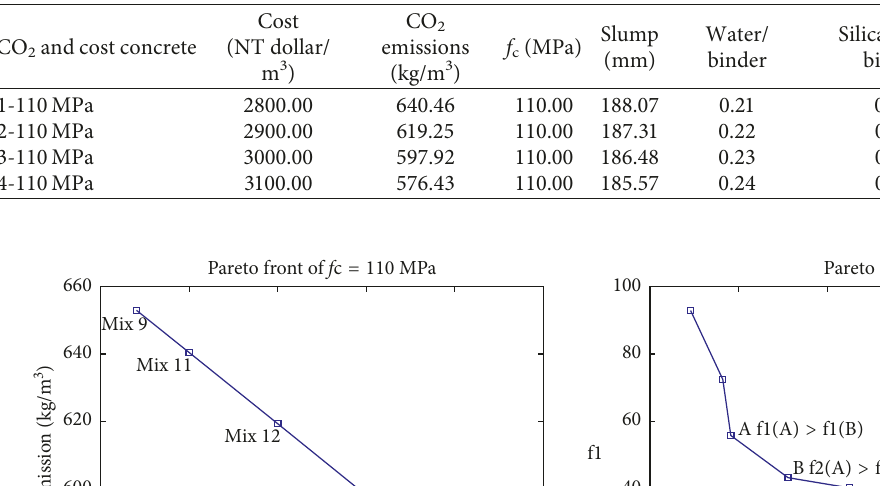
Table 10: Performance of 110 MPa concrete with lower CO